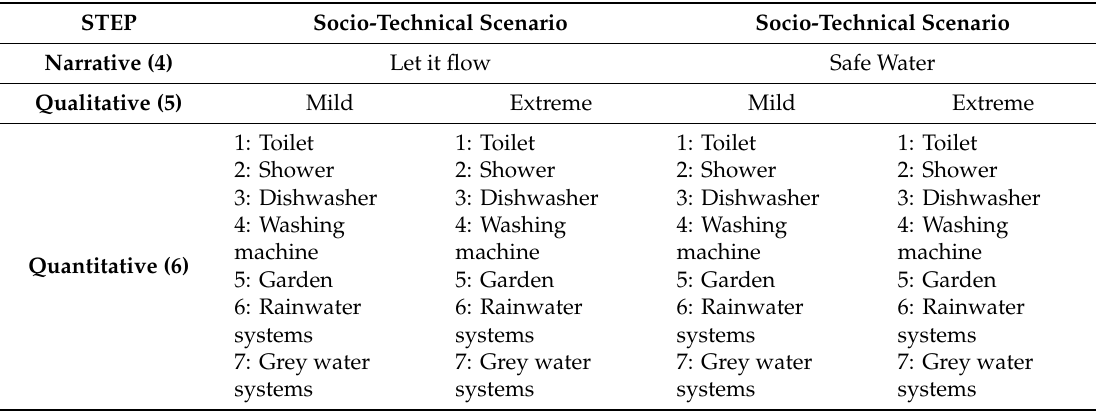
Table A1. Socio-technical scenarios